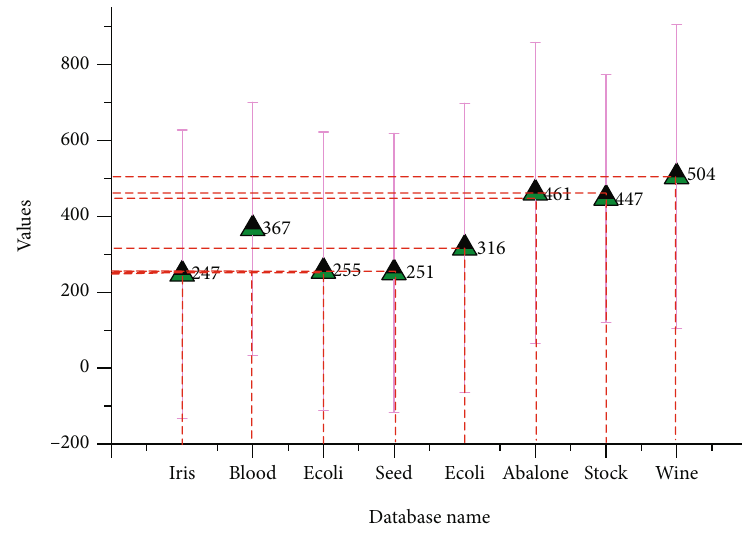
Figure 4: Experimental